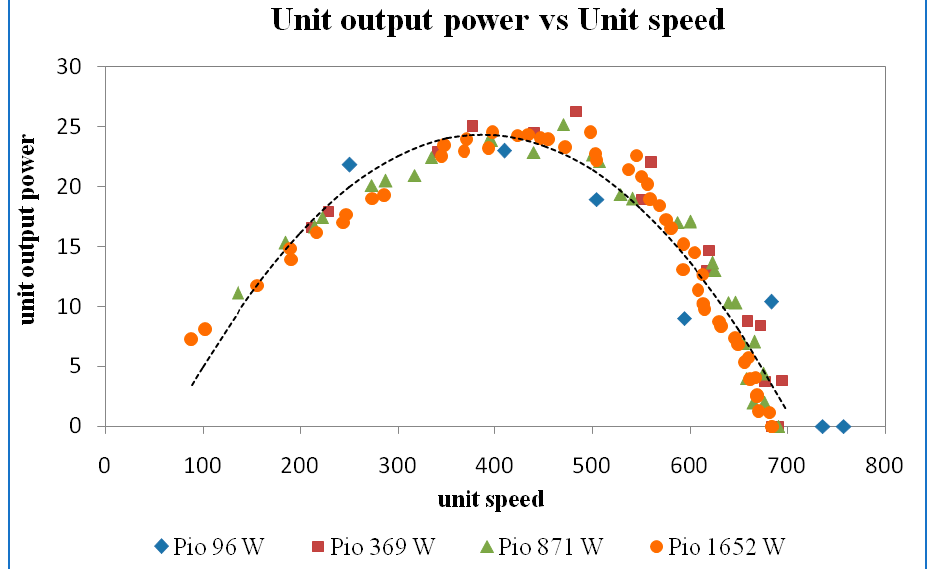
Figure 35. Unit output power vs. unit speed at a guide vane opening of 19 mm. Figure 36 shows the variation in efficiency with unit speed for GVO of 19 mm. It shows that the unit speed at BEP is 400